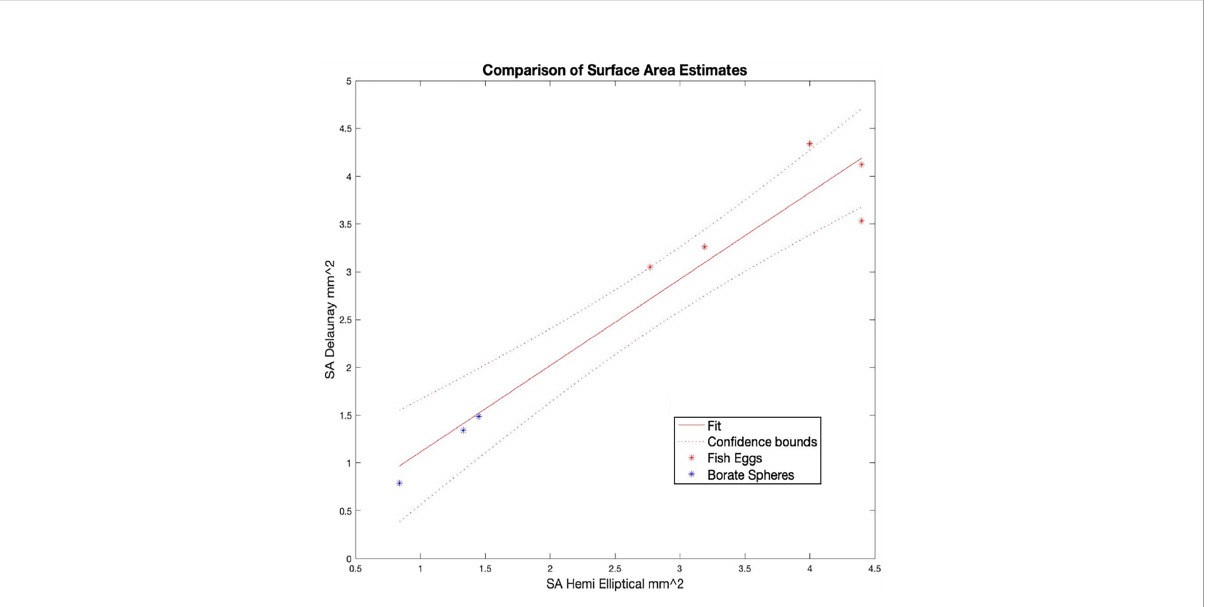
FIGURE 9 Comparison of surface area (SA) estimates for the calibration targets as calculated with two techniques: Delaunay triangulation of the point clouds from OCT scans that approximated the surface and the use of a formula to calculate the surface area of a 3D half ellipsoid given the lengths of the (3) semi-axes in X, Y, and Z. All data are listed in Table 1.